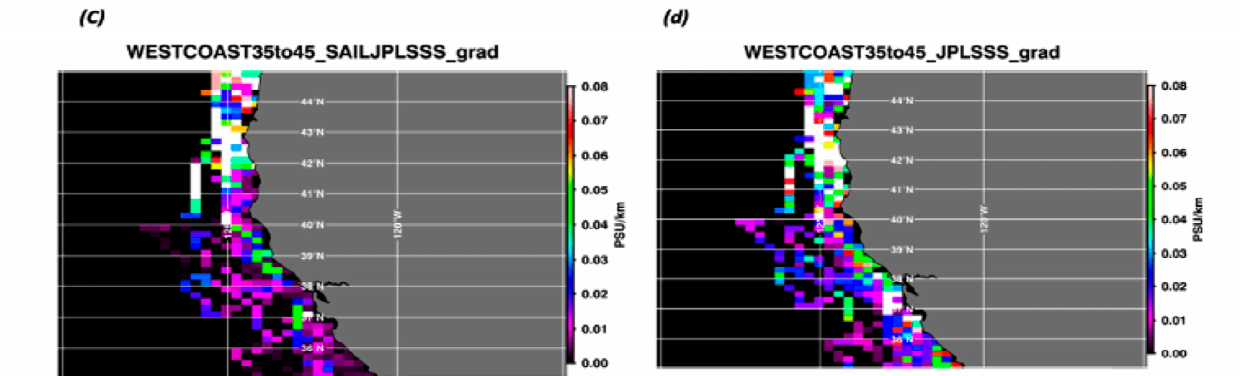
Figure 3. ( a – d ). ( a ) SAILSSS between 30°N to 35°N from the SBE/CTD based on the collocated JPLSSS and Saildrone deployment, ( b ) JPLSSS between 30°N to 35°N for the collocated JPLSSS prod- uct, ( c ) SAILSSS between 35°N to 45°N from the SBE/CTD based on the collocated JPLSSS and Sail- drone deployment, and ( d ) JPLSSS between 35°N to 42°N for the collocated JPLSSS product.